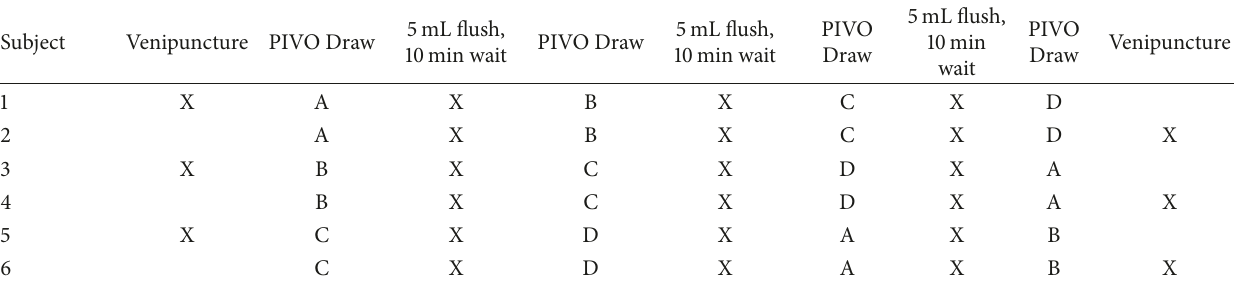
Table 2: Sample sequence of study procedures.